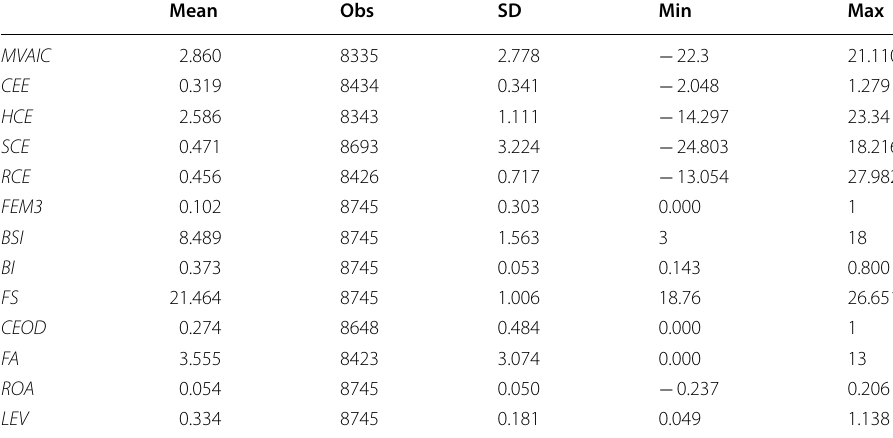
Table 2 Summary statistics